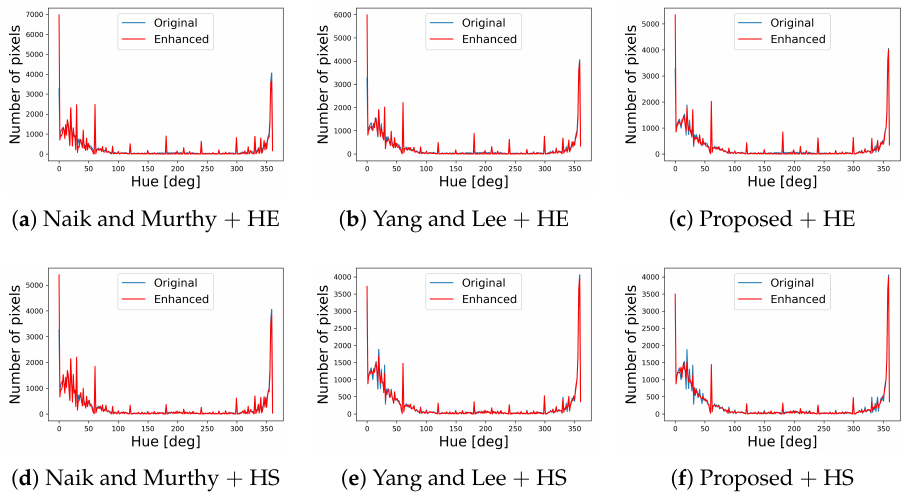
Figure 11. Hue histograms computed from the color images in Figure 6. In each graph, the blue line denotes the hue histogram of the original color image in Figure 2a, and the red line denotes that of the enhanced image by the corresponding method indicated in the subcaption.